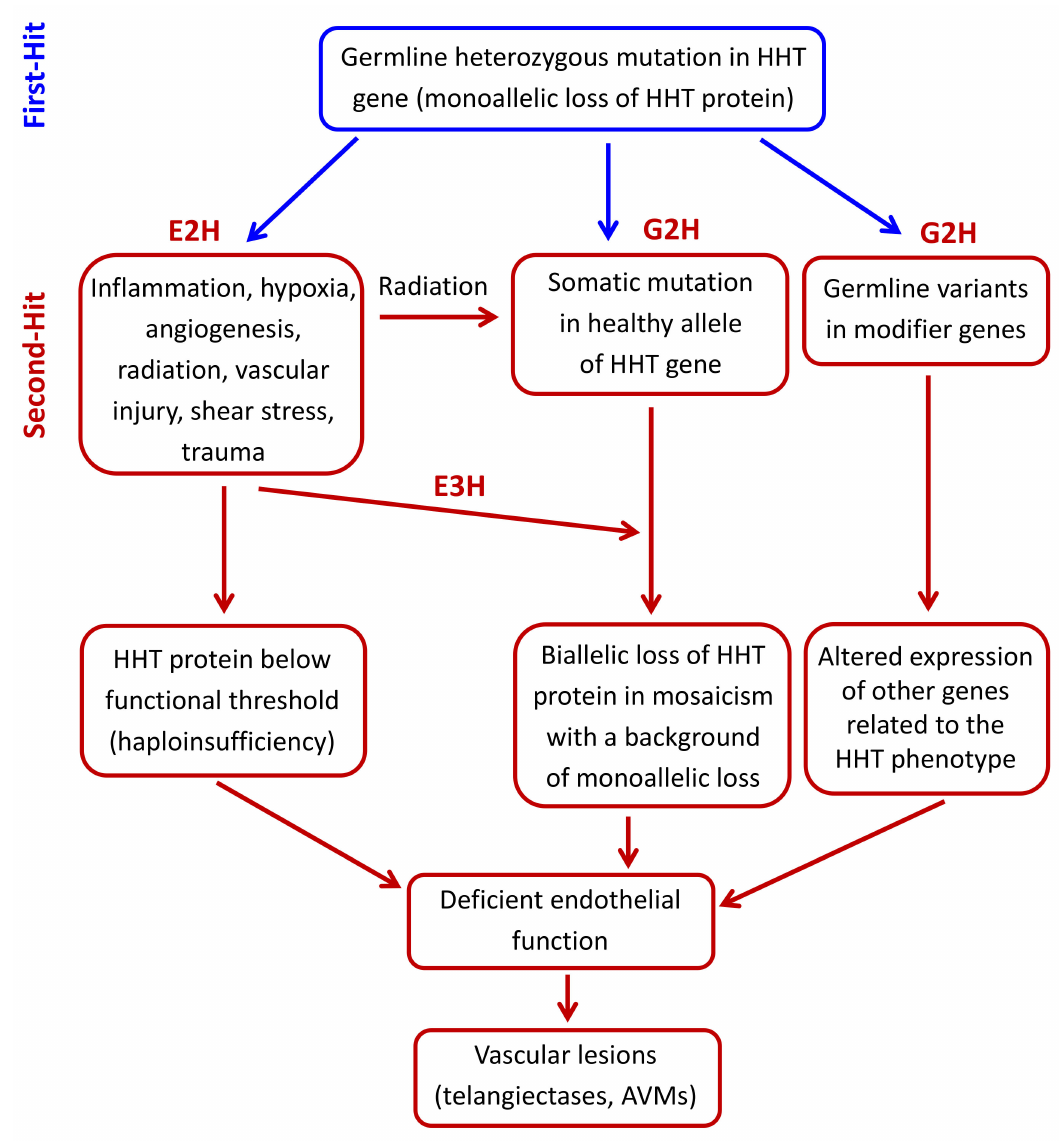
Figure 2. Hypothetical second-hit model in hereditary hemorrhagic telangiectasia (HHT). The germline heterozygous mutation in the HHT gene leads to a monoallelic loss of the encoded HHT protein in endothelial cells (First-hit). A subsequent environmental stimulus like inflammation, hypoxia, neoangiogenesis, vascular injury, radiation, shear stress, or trauma (environmental second-hit; E2H), can induce the expression / activation of mediators, which generate a microenvironment where HHT protein levels are below the needed functional threshold. This drop in the HHT functional protein can also be generated by a somatic mutation in the normal allele (genetic second-hit; G2H), leading to a focal protein loss in lesions. One possible cause of somatic mutation is sunlight radiation, especially in skin telangiectases. A somatic mutation could also synergize with an environmental third-hit (E3H). Modifier genes (G2H) could also contribute to focal vascular lesions by a ff ecting HHT protein level and activity. In all cases, the result is an impaired endothelial cell function, leading to the generation of telangiectases or arteriovenous malformations